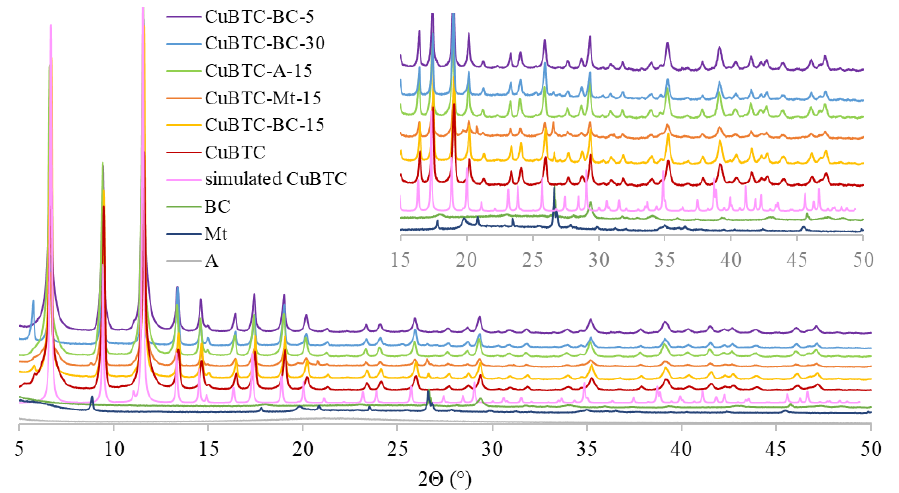
Figure 1. PXRD spectra of aerosil (A), montmorillonite (Mt), biochar (BC), CuBTC, CuBTC composites containing aerosil (CuBTC-A-15), montmorillonite (CuBTC-Mt-15), and PXRD patterns of CuBTC-composites containing different amounts of biochar (CuBTC-BC-5, CuBTC-BC-15, and CuBTC-BC-30, respectively). The patterns simulated from the crystal structure data of pure CuBTC are shown in pink color.